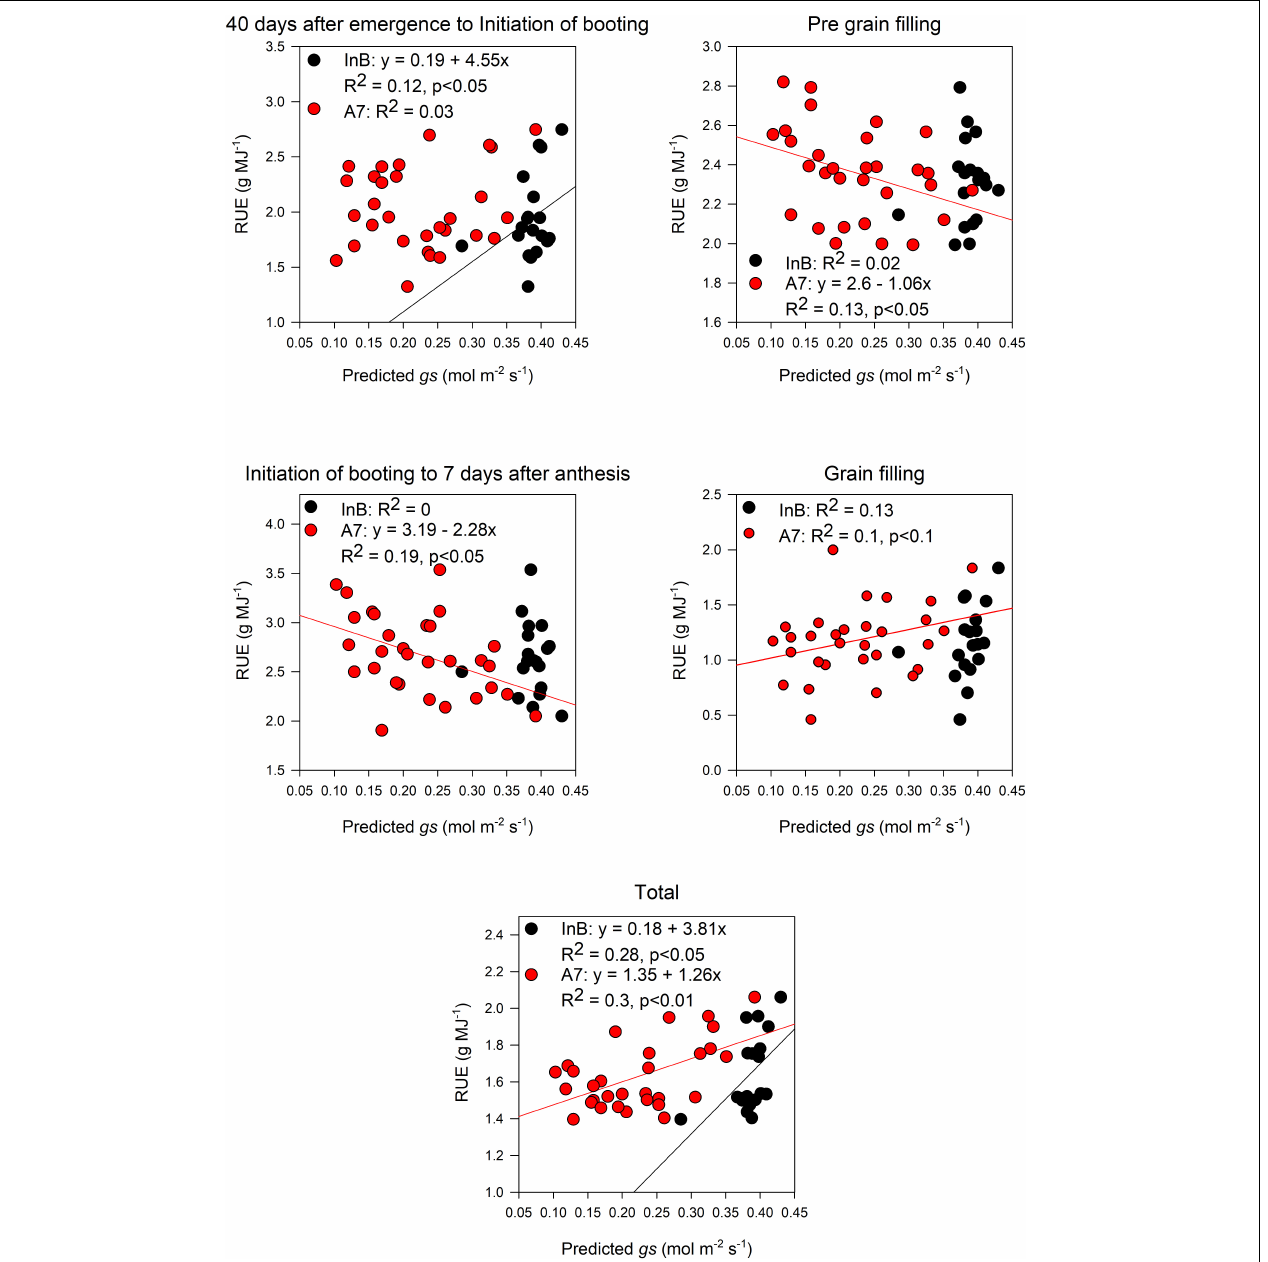
FIGURE 8 | Relationship between radiation use efficiency measured at different growth periods and predictions of stomatal conductance average throughout the canopy estimated from the PLSR models. Black dots represent predictions from initiation of booting and red dots predictions from 7 days after anthesis. Data shown are the observed vs predicted bilinear unbiased estimator (BLUEs) in 2 years of study (initiation of booting, n = 19) and 3 years of study (7 days after anthesis, n = 30). Lines represent the linear regression when statistically significant relationships were